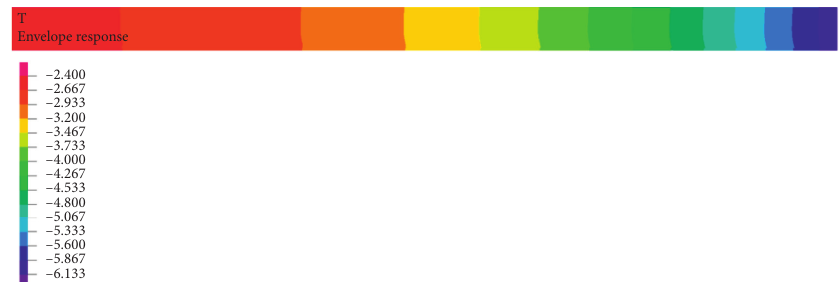
Figure 26: Annual average air temperature distribution in the tunnel axis at a depth of 30 m.